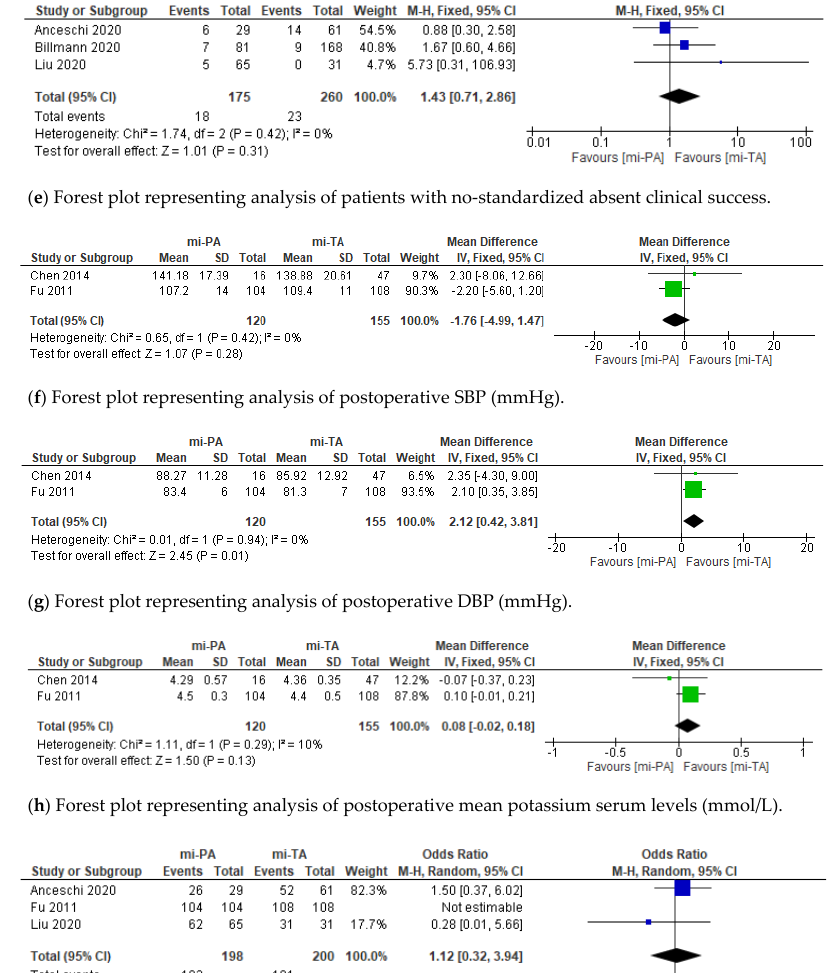
variance; SD = standard deviation; CI = confidence interval; M ‐ H = Mantel ‐ Haenszel. Each studies